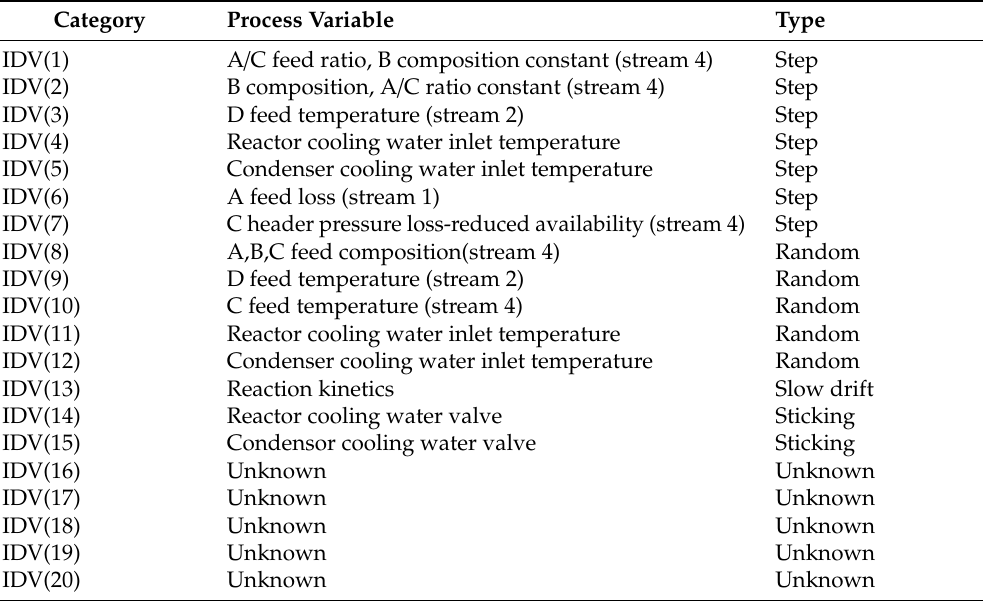
Table 5. IDVs (vector of disturbance flags) category of TE